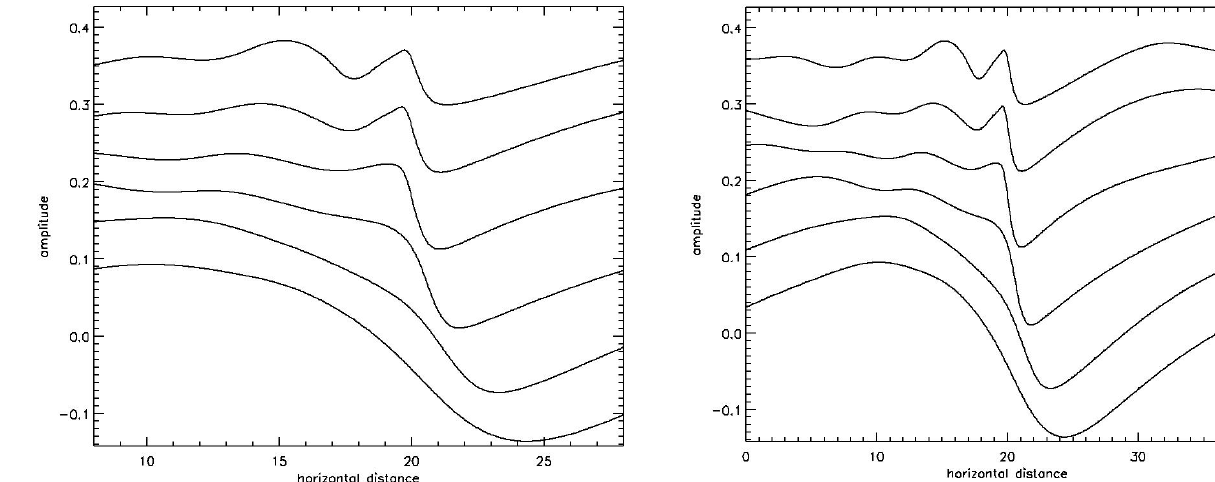
Fig. 12. Horizontal velocity plots taken from a deep domain run initialized with a velocity duct for which the horizontal domain and wavelength were increased. Note that this is a subsection of the horizontal computational domain in order that direct comparison with Fig. 12 may more easily be made. Times are 38, 47, 56, 66, 75, 83.